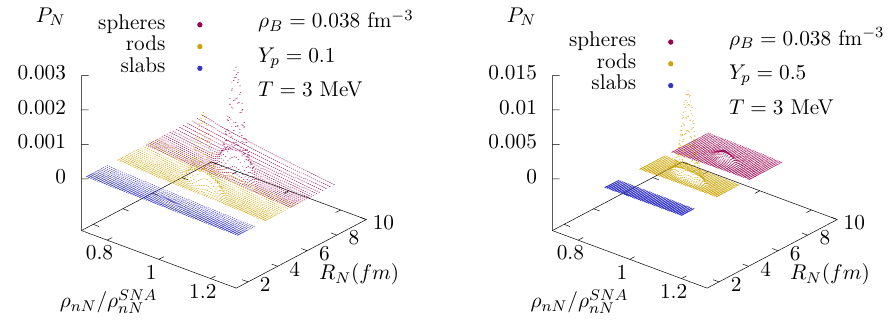
Figure 18. 3D probability distribution as a function of the pasta linear dimension and the normalized cluster density with different geometries obtained with the IUFSU parametrization for different proton fractions. Notice the vertical scale